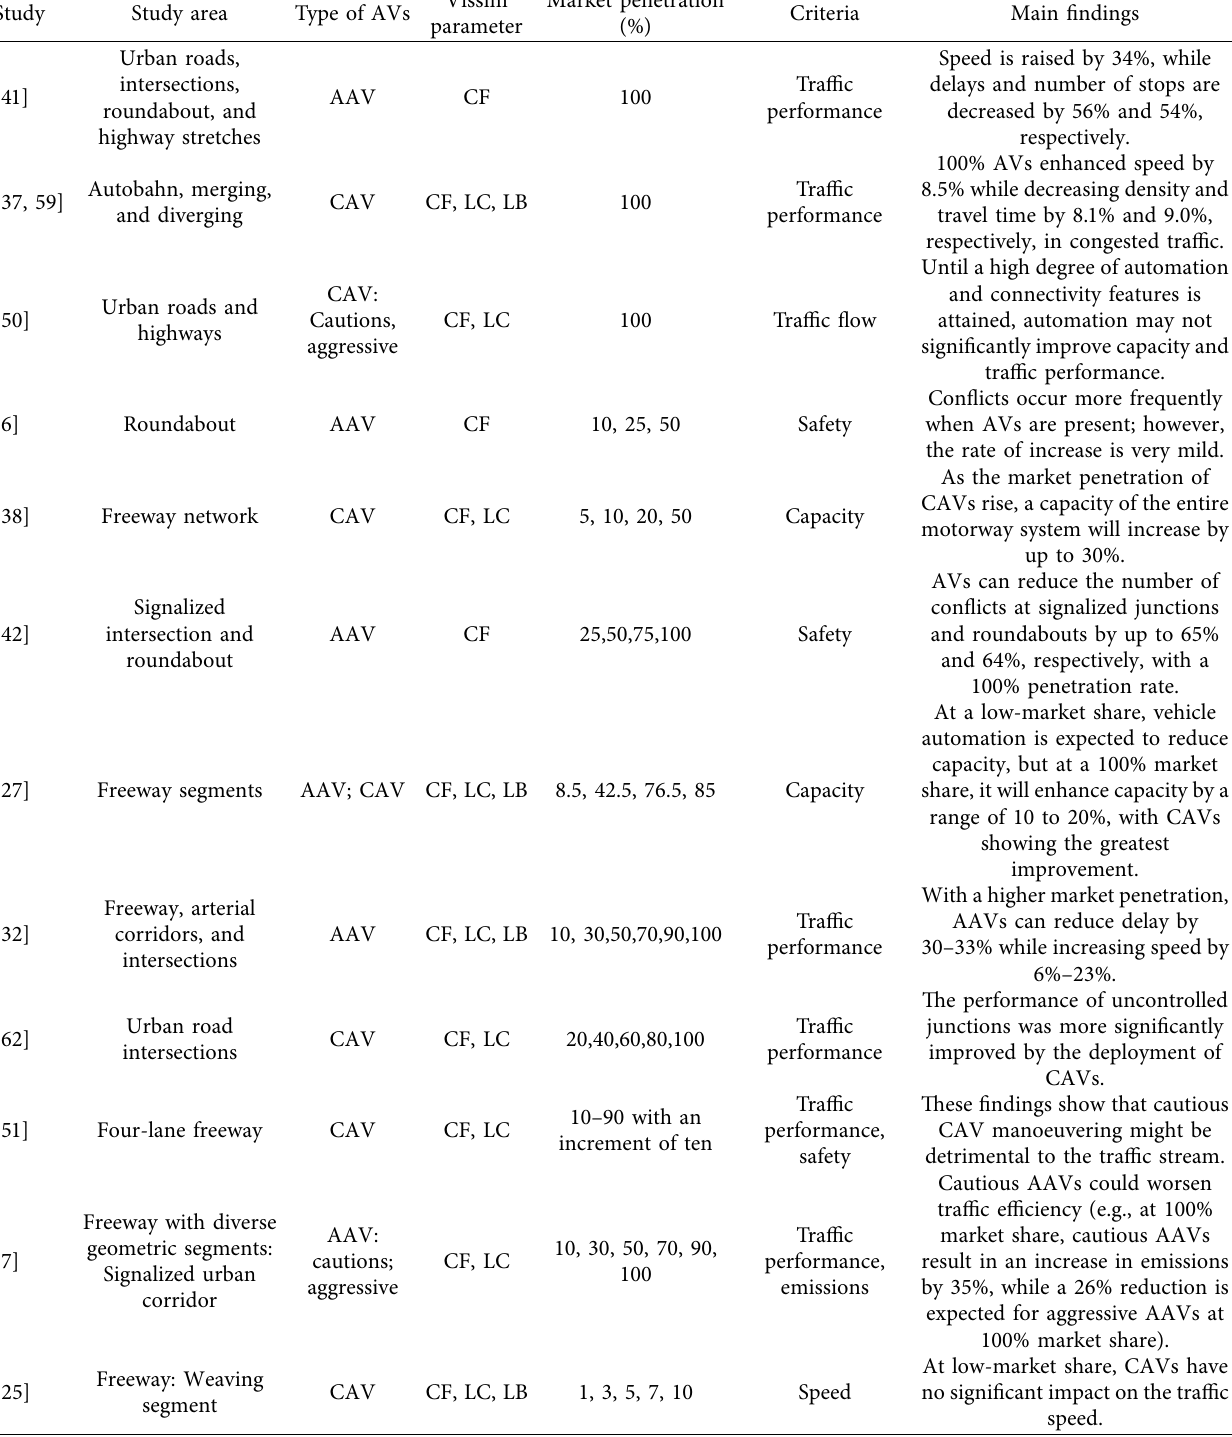
Table 3: Existing studies on simulations of AVs in different types of roadways through the PTV Vissim internal model.